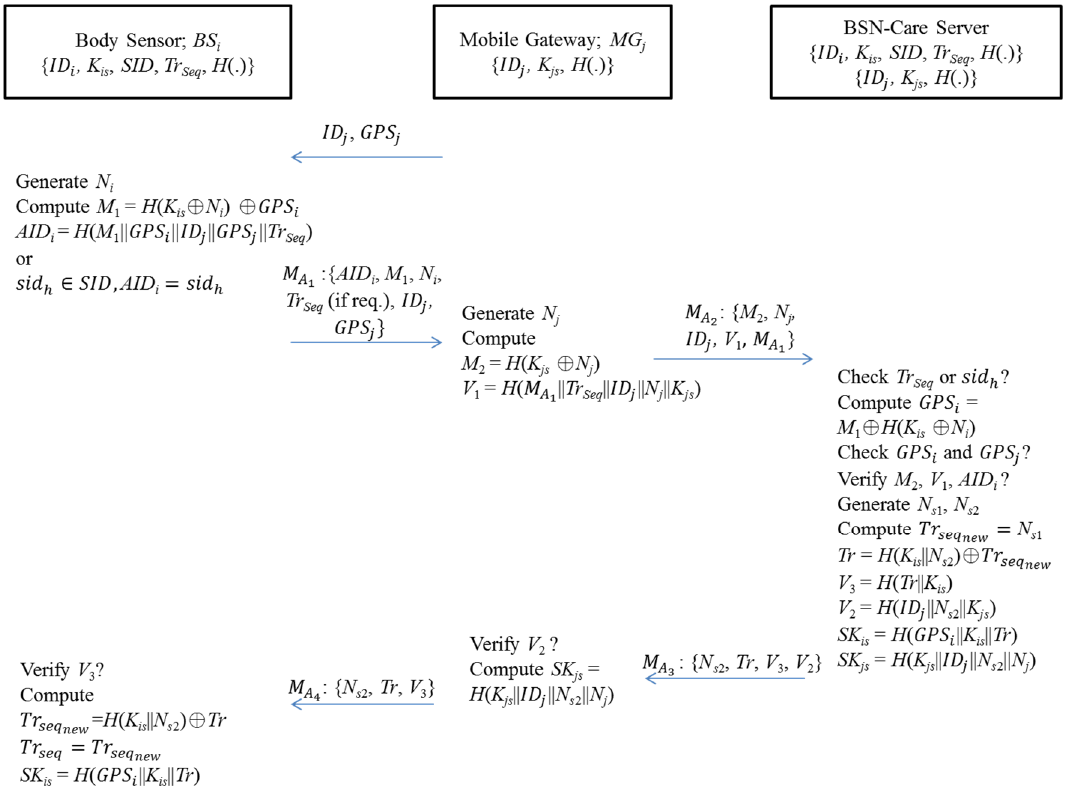
Figure 3. The authentication process of BSNCare+.